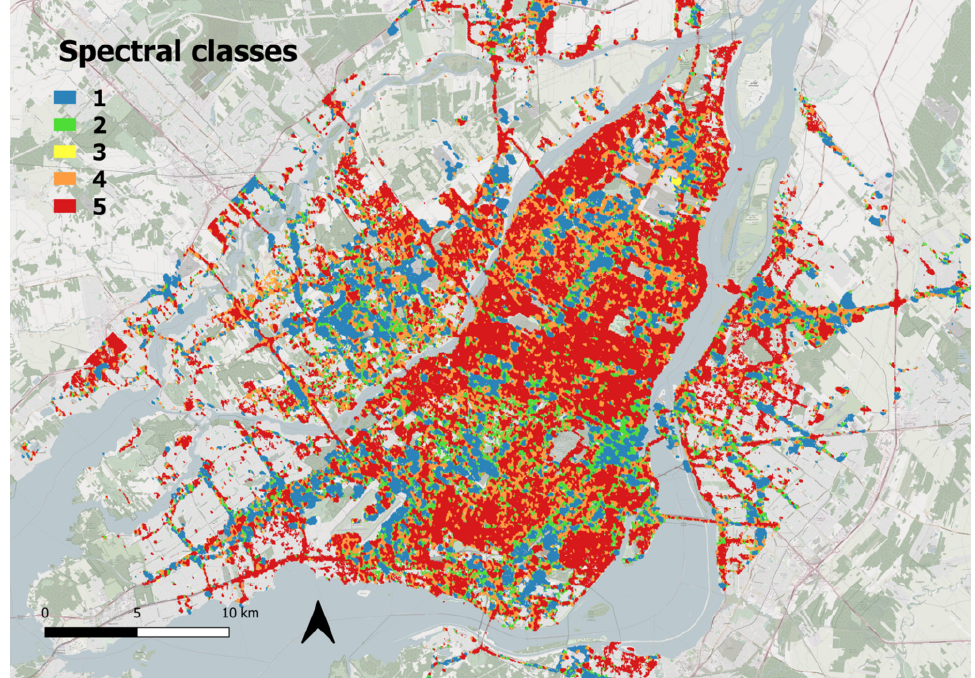
Figure 3. Filtered spectral classes image of Montréal from the ISS taken on 6 April